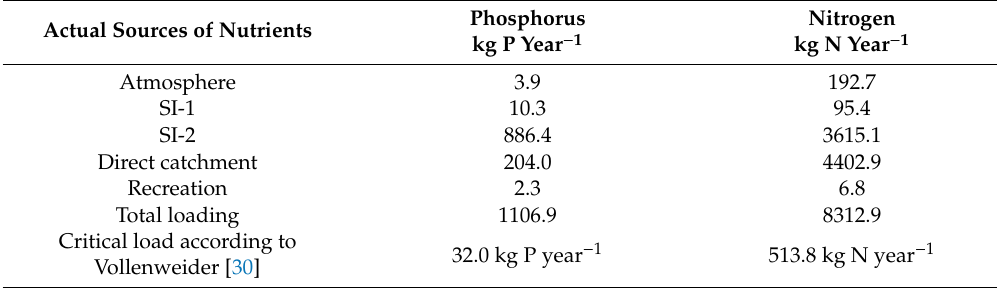
Table 7. Summary of protective and restoration activities for Miłkowskie